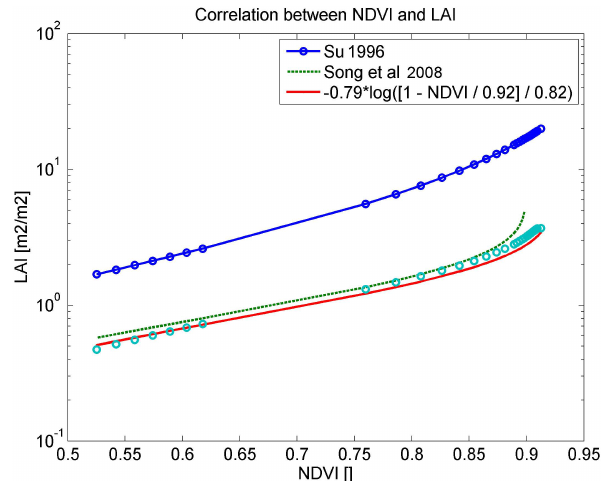
Fig. 3. NDVI – LAI relationships. The LAI values obtained by mea- surements (open circles) and the Su (line with closed circles) and Song parameterizations are shown. The Song parameterization is shown with its original values (the green dotted) for A and B and also for the optimized values (solid red